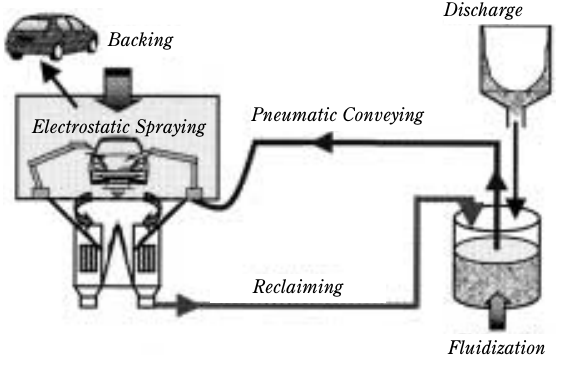
Schematic diagram of industrial application process